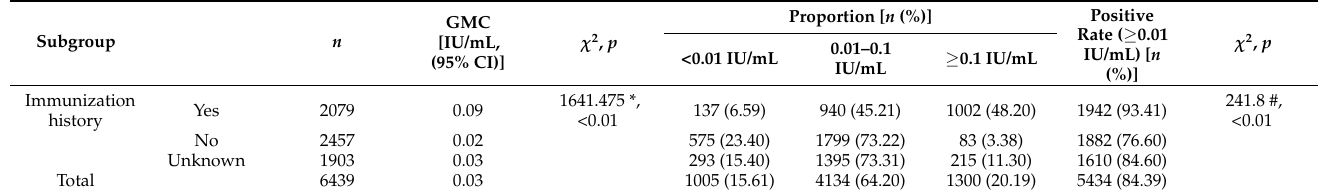
Table 3. The immunization history of tetanus-toxoid-containing vaccines (TTCVs) among 6439 subjects enrolled in this study.